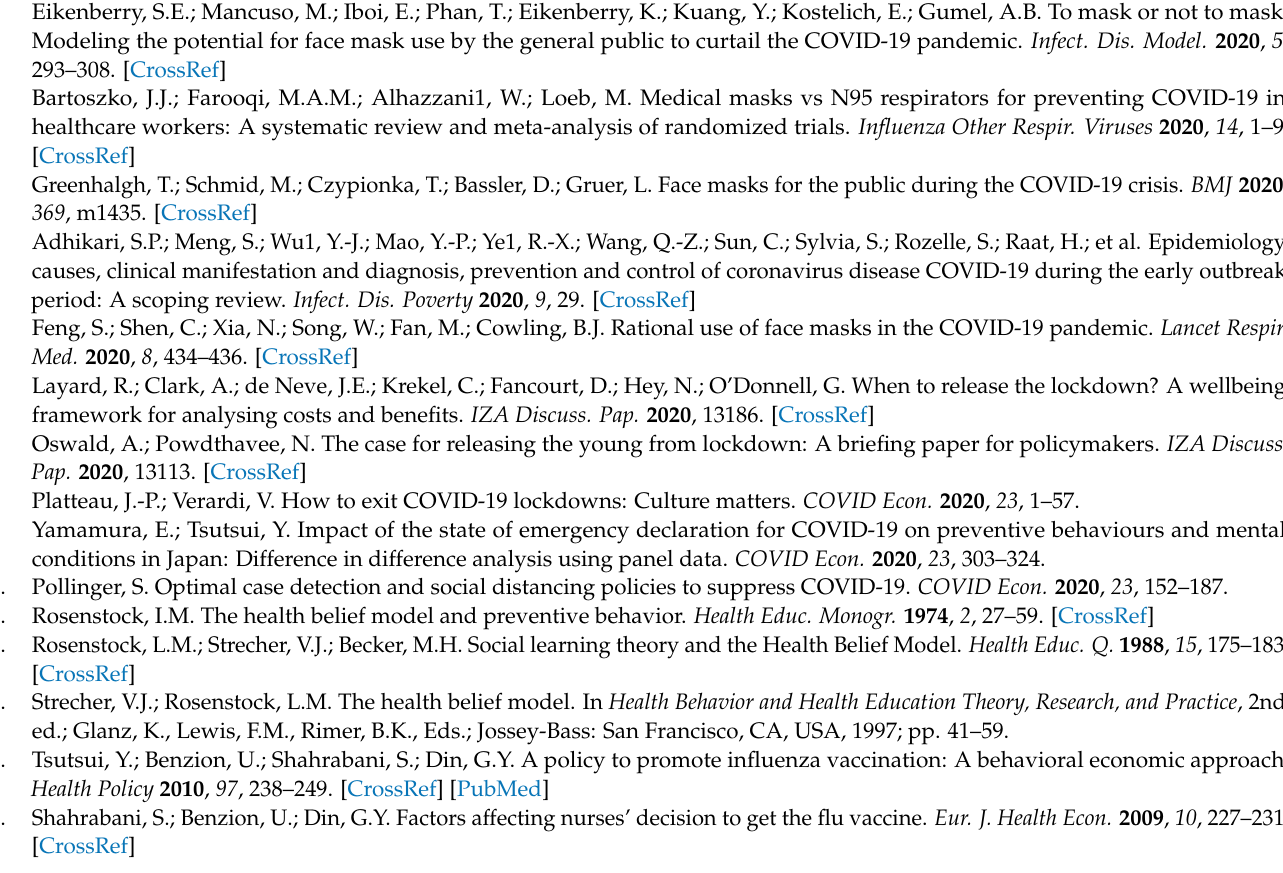
Figure S2: Distribution of the answers of SEVERITY for each wave, Figure S3: Distribution of the answers of probability of infection (PROB) for each wave, Figure S4: Distribution of risk attitude of each wave, Figure S5: Magnitude of the variables at each wave, Figure S6: Sensitivity of VACCINE on each variable at each